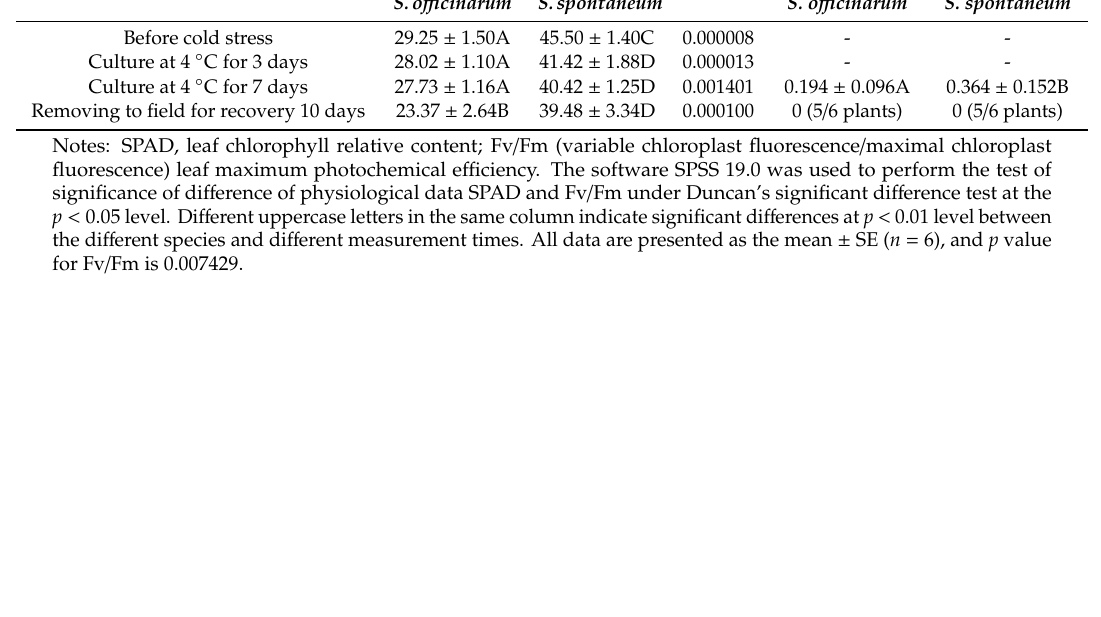
Table 5. The values of SPAD and Fv / Fm measured in two sugarcane ancestors of Saccharum . Investigate